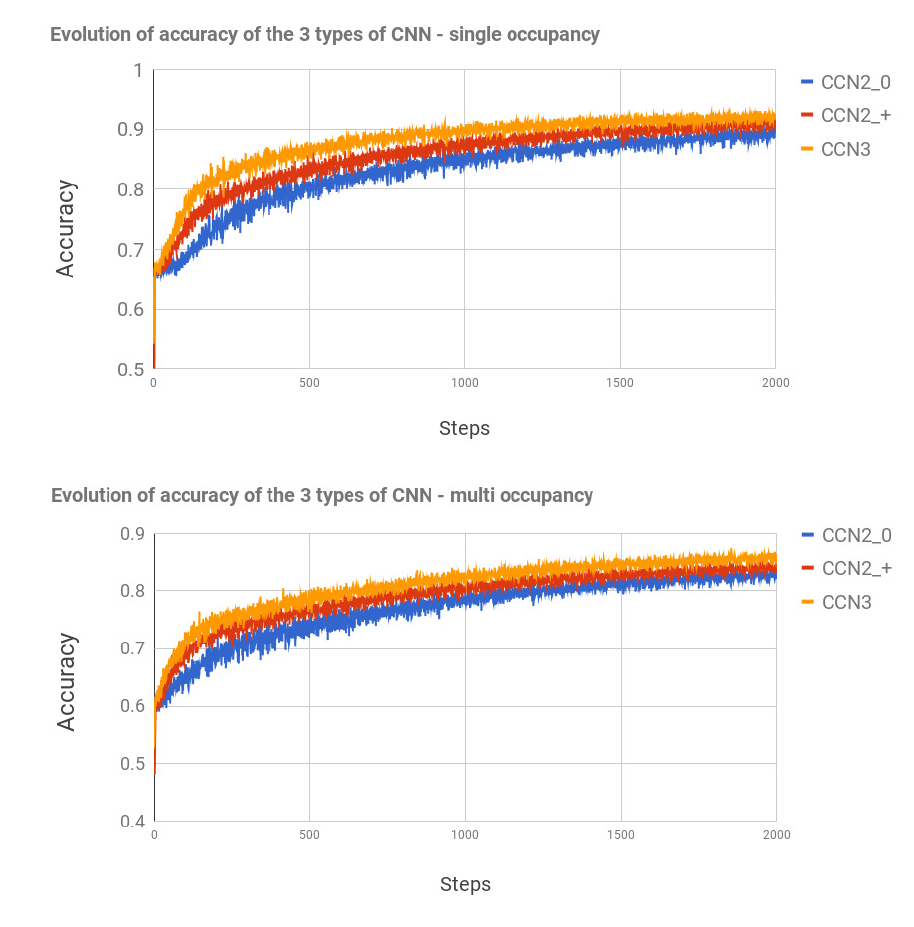
Figure 3. Evolution of accuracy in the learning process for single and multi occupancy from the 3 types of CNNs. Table 2. Table summarizing the results of the single occupancy data.